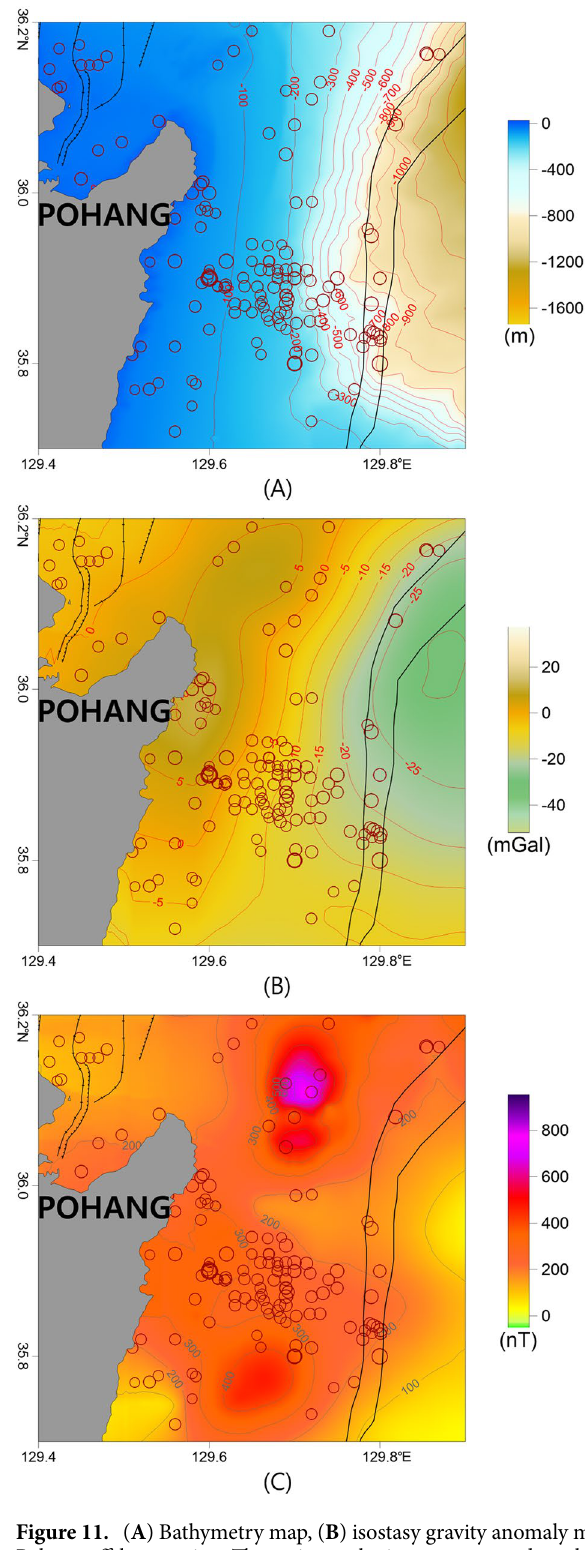
Figure 11. ( A ) Bathymetry map, ( B ) isostasy gravity anomaly map, and ( C ) RTP magnetic anomaly map of the Pohang offshore region. The major geologic structures and symbols of the earthquakes are the same as those in Fig. 2. These figures were generated using the Surfer software (https:// www. golde nsoft ware.